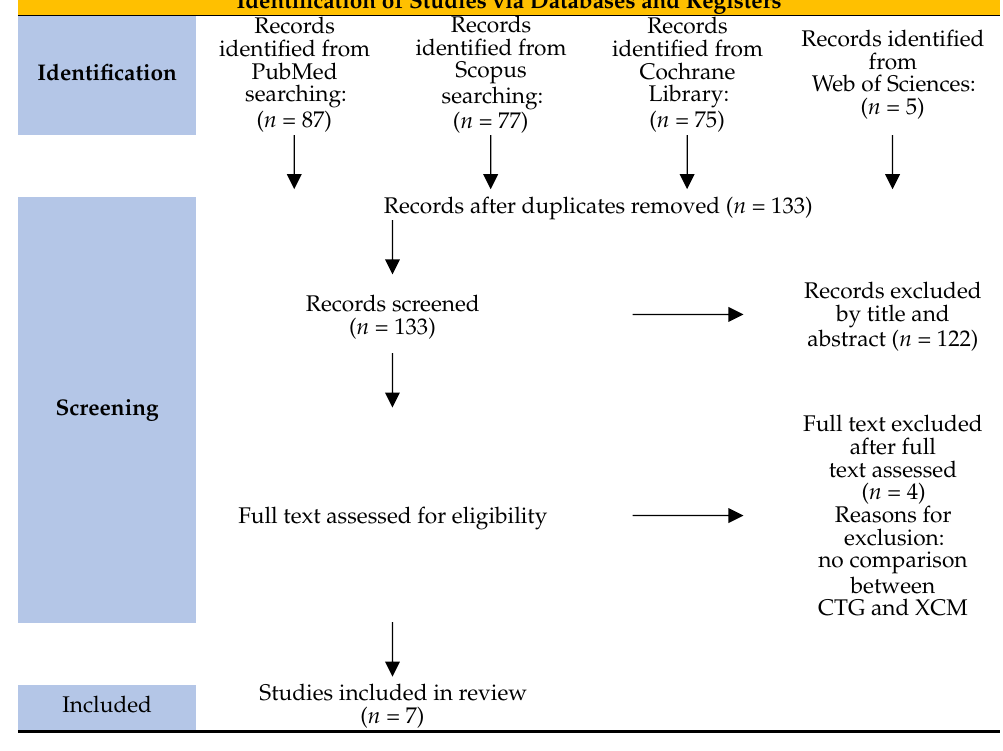
Table 1. PRISMA flow chart .